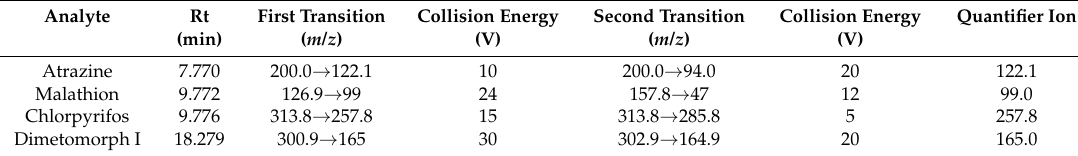
Table 1. Summary of the selected parameters for each